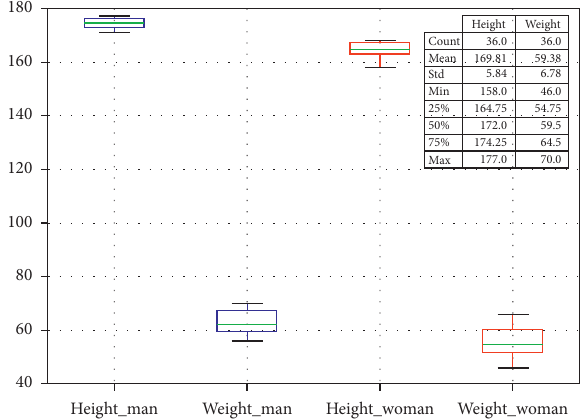
Figure 1: Weight and height information about volunteers